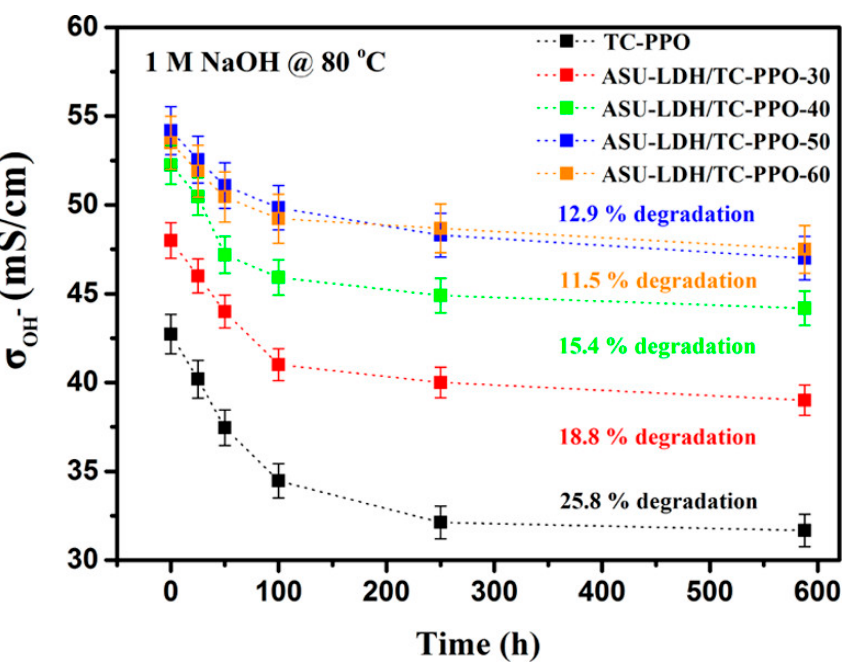
Figure 7. Hydroxide conductivity variations vs. time of TC ‐ PPO and hybrid membranes with ASU ‐ LDH at 30 °C. Reprinted with permission from Ref. [45]. Copyright (2018) American Chemical Society.